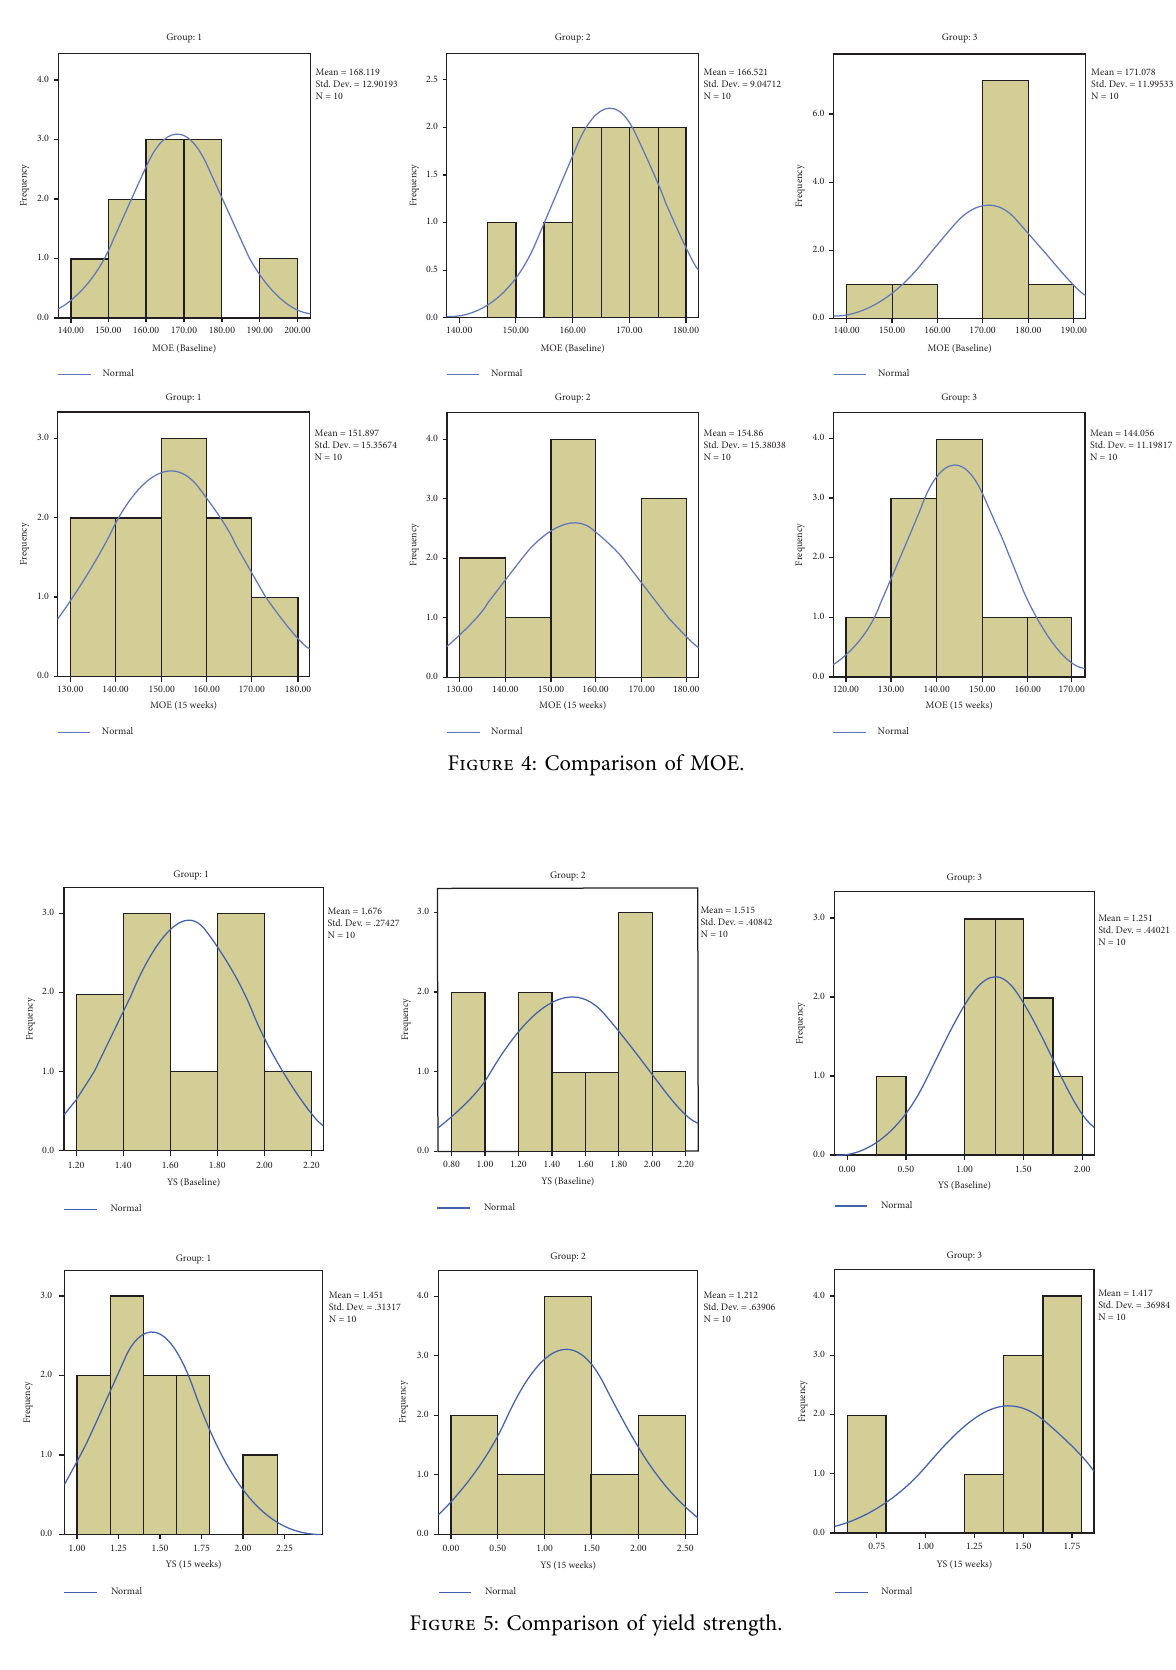
Figure 5: Comparison of yield